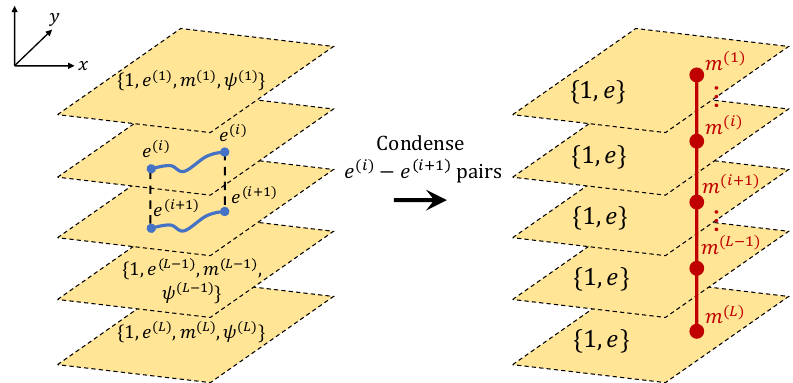
Figure 19: Condensation of the pair of e -charges e ( j ) e ( j + 1 ) in the L layers of 2d (cid:90) toric codes. The deconfined excitations after the condensation is given by a single e -charge e ( j ) , and the m -flux string given by an array of m -anyons in all